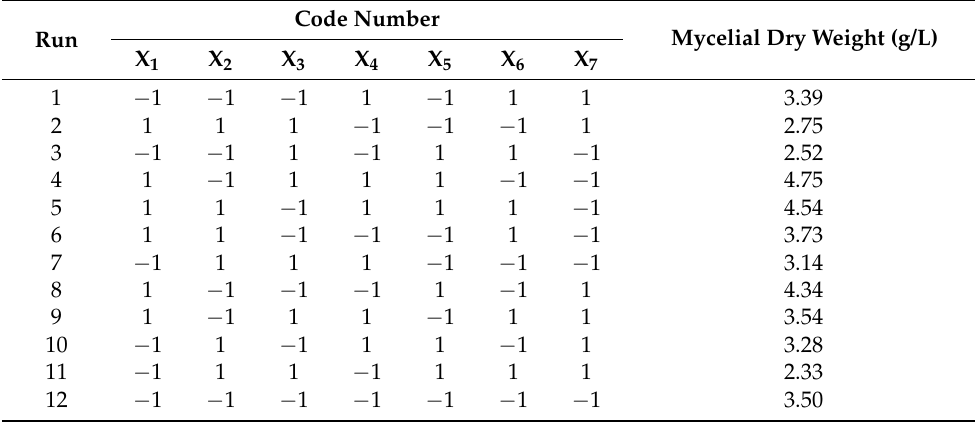
Table 3. The design and results of